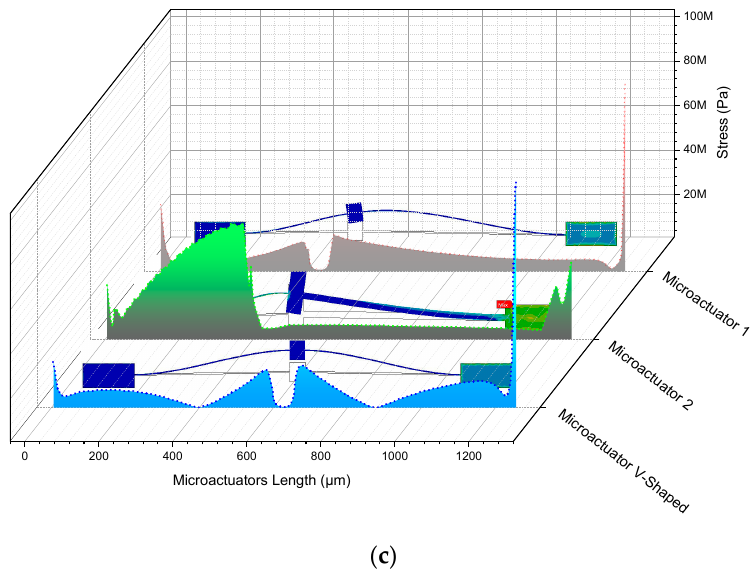
Figure 8. ( a ) Force, and ( b ) 2D and ( c ) 3D graph of equivalent von Mises stress microactuators 1, 2, and V-shaped.